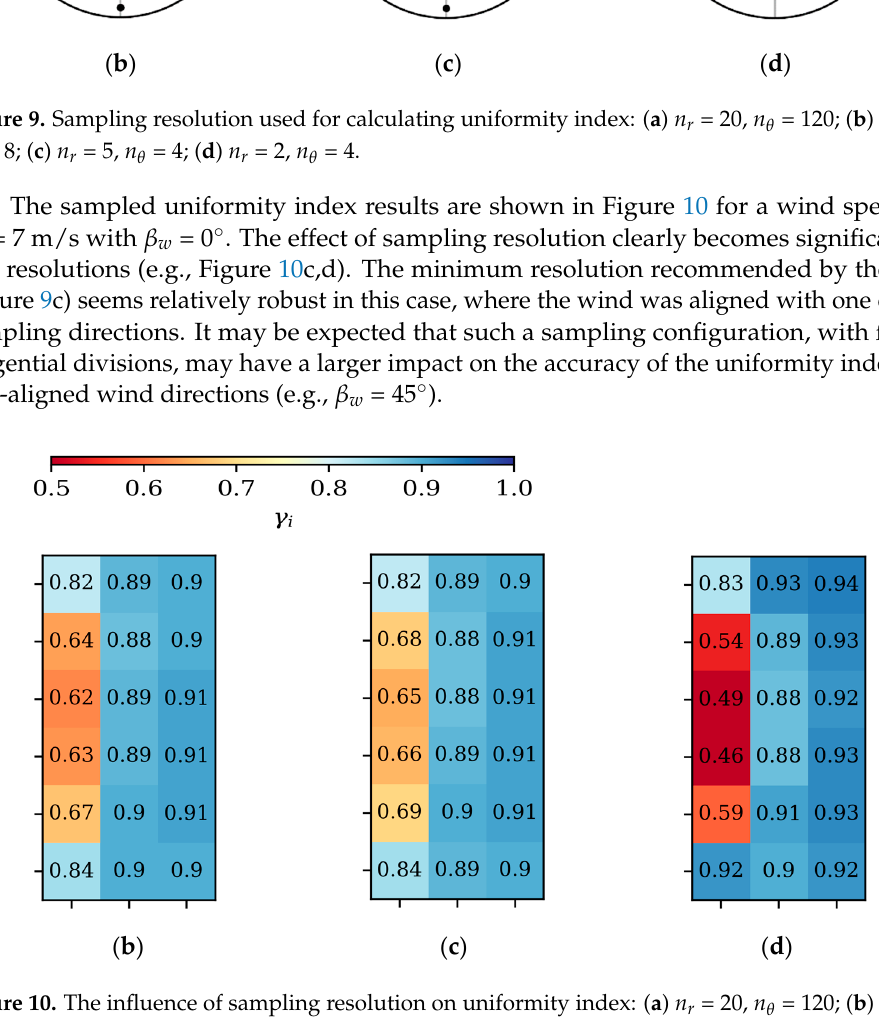
Figure 9. Sampling resolution used for calculating uniformity index: ( a ) n r = 20, n θ = 120; ( b ) n r = 5, n θ = 8; ( c ) n r = 5, n θ = 4; ( d ) n r = 2, n θ = 4.